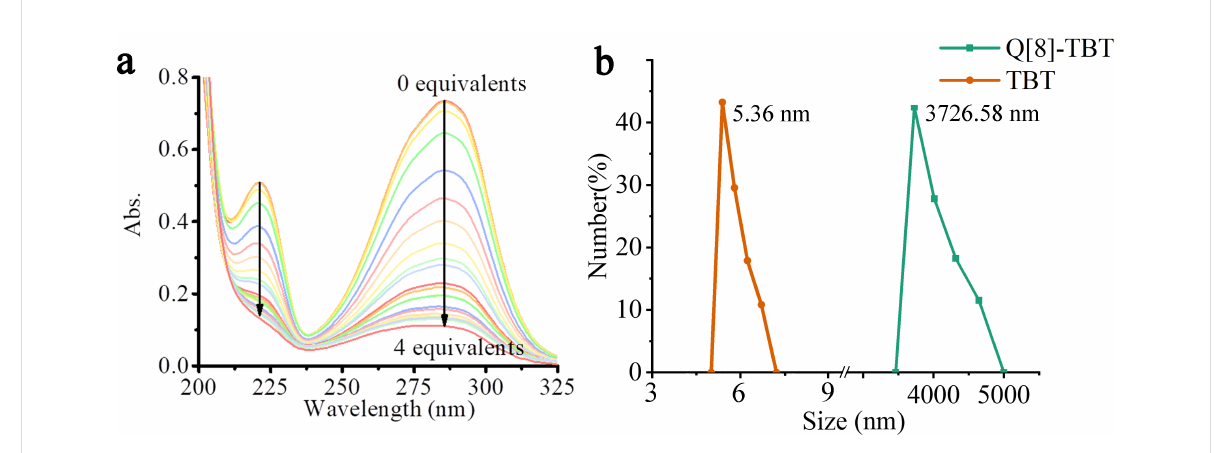
Figure 4: The UV–vis spectra (a) of TBT (20 μ M) with an increasing amount of Q[8] from 0.0 to 4.0 equiv and the DLS of TBT (20 μ M) and Q[8]-TBT (3:1, 20 μ M).